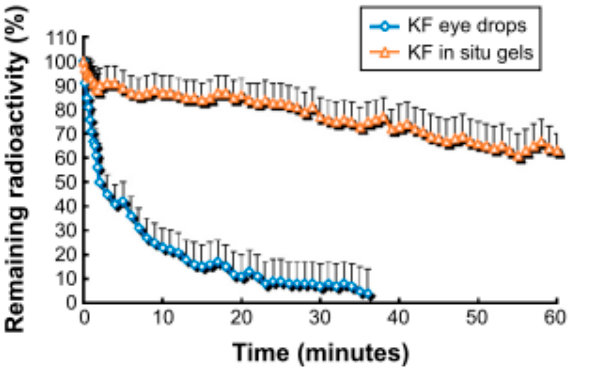
Figure 11. Corneal surface clearance of two formulations incorporating 99 mTc-DTPa [117].